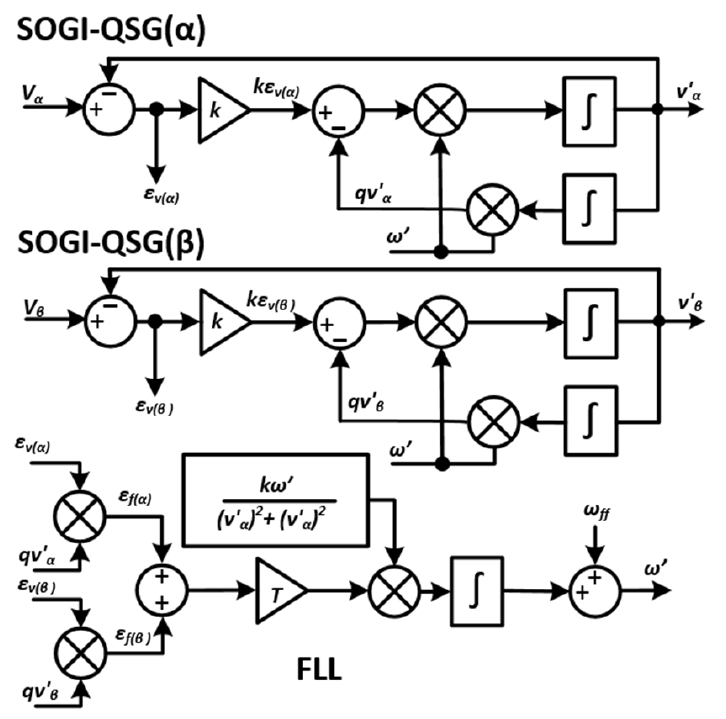
Figure 5. DSOGI-FLL algorithm, where: qV’ α and qV’ β —signals in quadrature phase. In the next step, the phase and quadrature-phase components are multiplied by each other. The sum of components is normalized by two constant factors and integrated. The frequency estimated in that way is extremely stable when compared with other presented methods of frequency estimations, even in the presence of voltage disturbances. This high stability is coming at the cost of a slow response to the quick-changing input